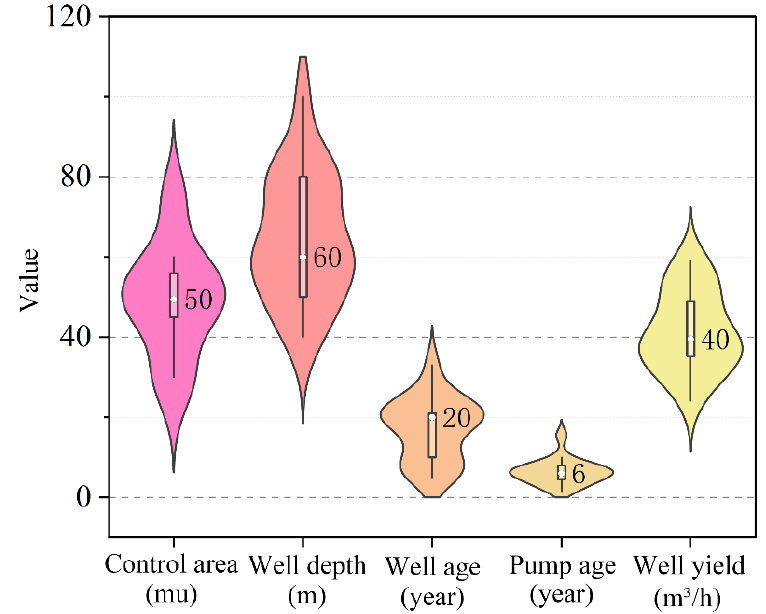
Figure 1. Basic parameters of Wells. One mu equals to 667 m 2.